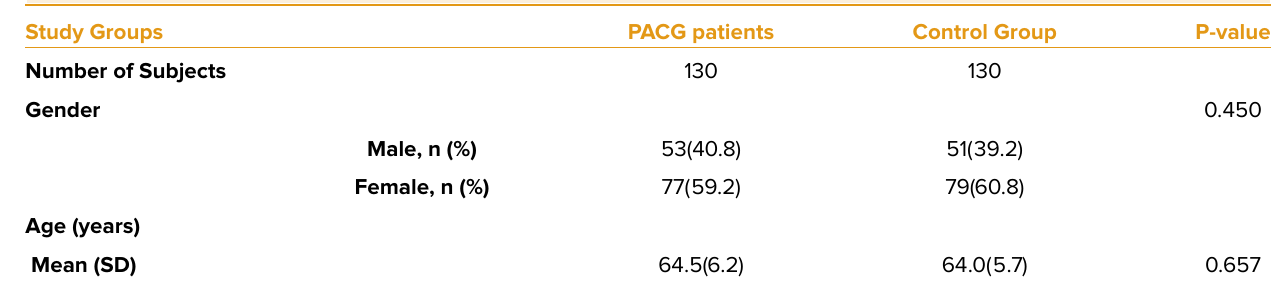
Table 2. Characteristics of the study